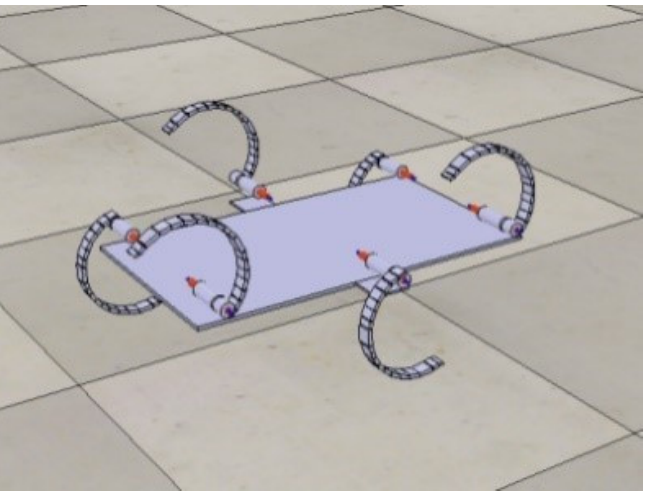
Figure 7. V-REP simulation of the robot.